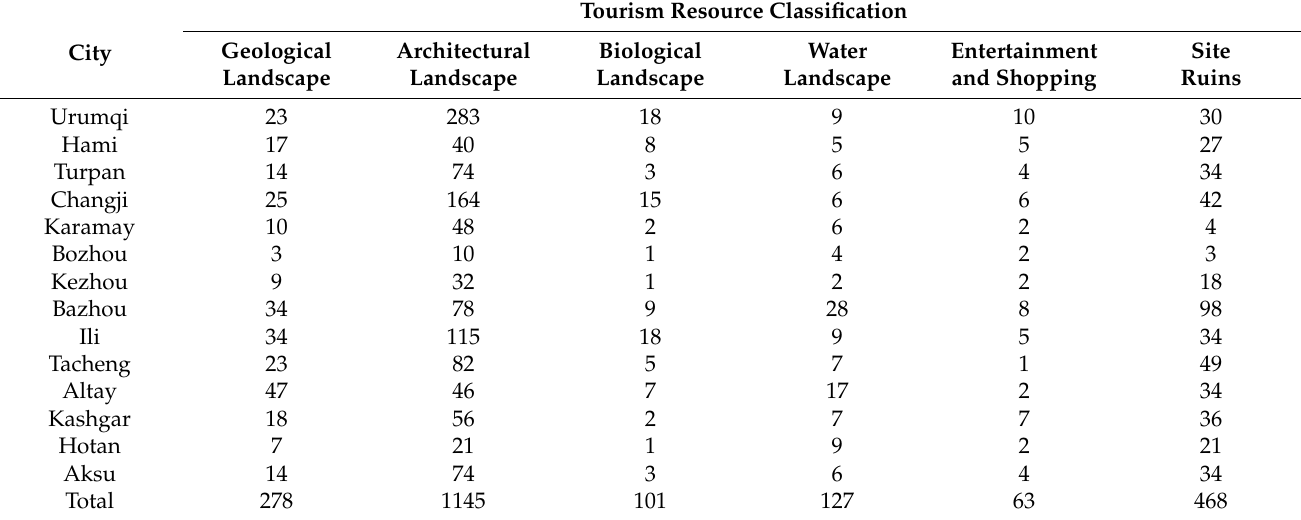
Table 2. Classified statistics of tourism resources in